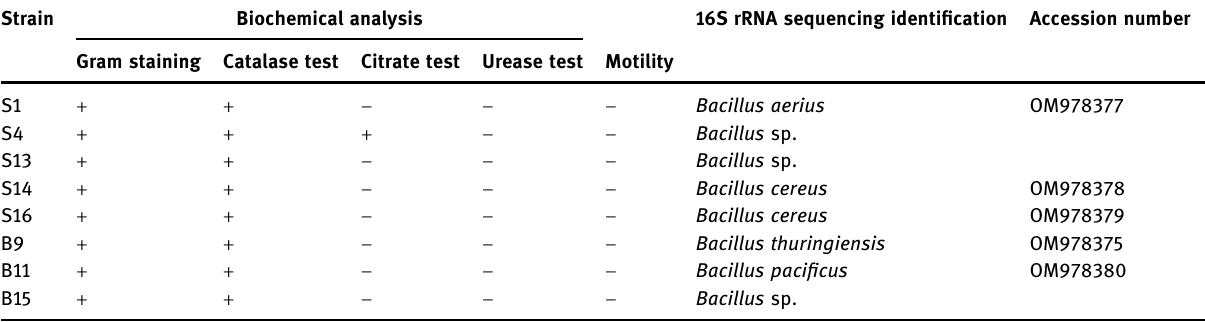
Table 2: Biochemical characteristics and molecular correspondence of bacterial isolates